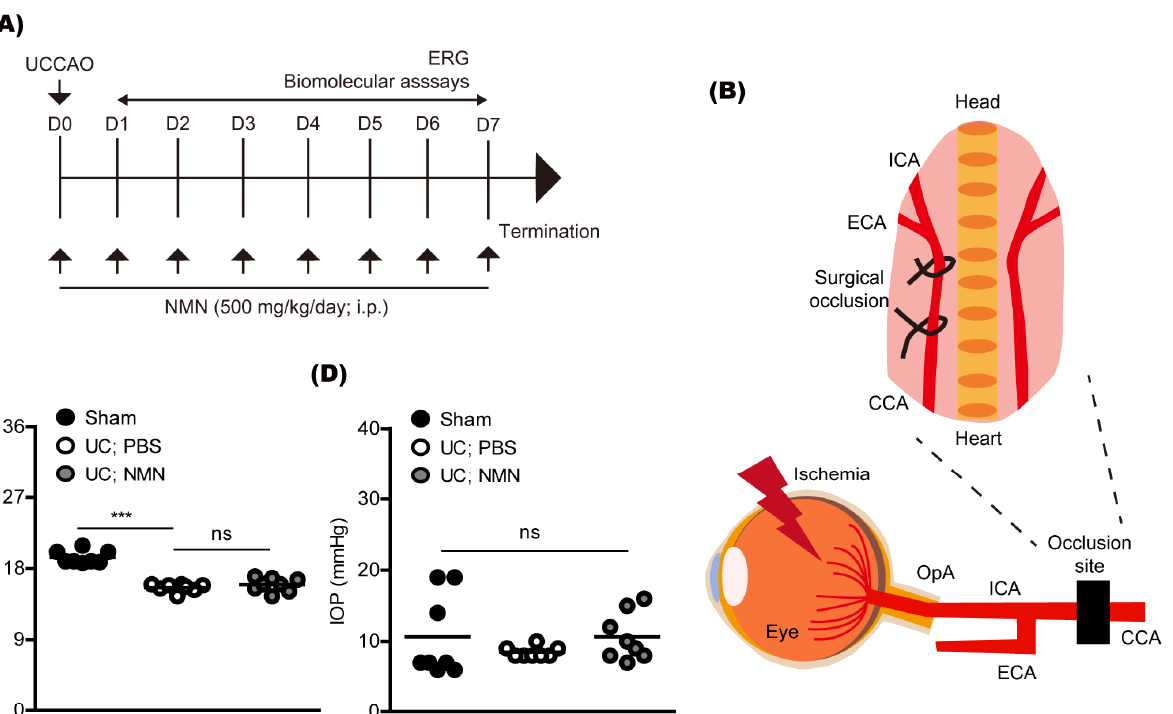
Figure 1. Retinal functional protection by continuous NMN treatment. ( A ) A general experimental scheme. UCCAO, unilateral common carotid artery occlusion; D, day; ERG, electroretinography; i.p., intraperitoneal injection; NMN, nicotinamide mononucleotide. ( B ) An anatomical view on the induction of retinal ischemia by surgical UCCAO. Surgical permanent occlusion of the common carotid artery (CCA) could induce occlusion of the internal carotid artery (ICA), finally leading to occlusion of the ophthalmic artery (OpA) which supplies the retina. ( C ) Quantitative analyses (n = 8 per group) demonstrated that the body weight was significantly reduced by UCCAO. There was no dramatic difference in the body weight between PBS-treated and NMN-treated UCCAO-operated mice. *** p < 0.001; ns, not significant. One-way ANOVA followed by a Bonfer- roni post hoc test. A graph is shown as mean with actual values (mean and standard deviation, sham: 19.41, 0.83; UC; PBS: 15.60, 0.50; UC; NMN: 15.94, 0.86). ( D ) Quantitative analyses (n = 8 per group) demonstrated that there was no difference in intraocular pressure (IOP) among all group. ns, not significant. One-way ANOVA followed by a Bonferroni post hoc test. A graph is shown as mean with actual values (mean and standard deviation, sham: 10.63, 5.78; UC; PBS: 8.50, 0.75; UC; NMN: 10.63, 3.37). ( E , F ) Representative waveforms (2 cd.s/m 2 ) of ERG and quantitative analyses (n = 7–12 per group) demonstrated that the ERG amplitudes decreased 7 days after UCCAO. NMN treatment suppressed reductions in the ERG amplitudes, flashed with various standardized inten- sities (0.1, 0.5, 2, 10, or 50 cd.s/m 2 ). * p < 0.05, ** p < 0.01, *** p < 0.001; # p < 0.05, ## p < 0.01, ### p <